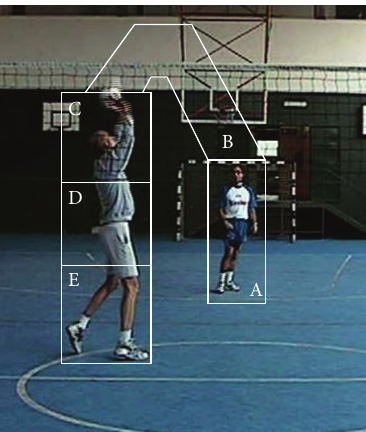
Figure 1: Viewpoint of the participant showing the setter’s hands- ball contact. White lines delineate the interest areas. A = IA-1, coach; B = IA-2, ball trajectory; C = IA-3, setter’s hands; D = IA-4, setter’s trunk; and E = IA-5, setter’s legs. Areas external to the contours are considered as